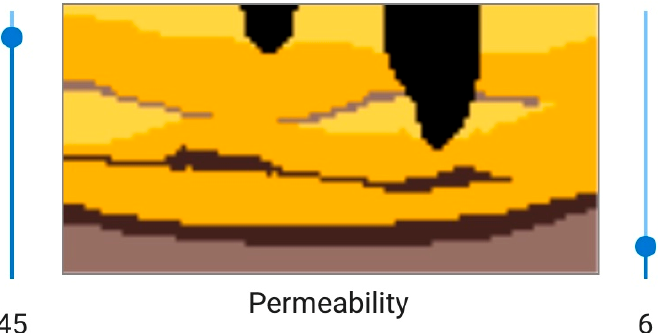
Figure 6. A simplified version of the ParFlow Sandtank, which is running the integrated hydrology model ParFlow. This simulation generates the “goal” output for ML model performance in Sandtank-ML.